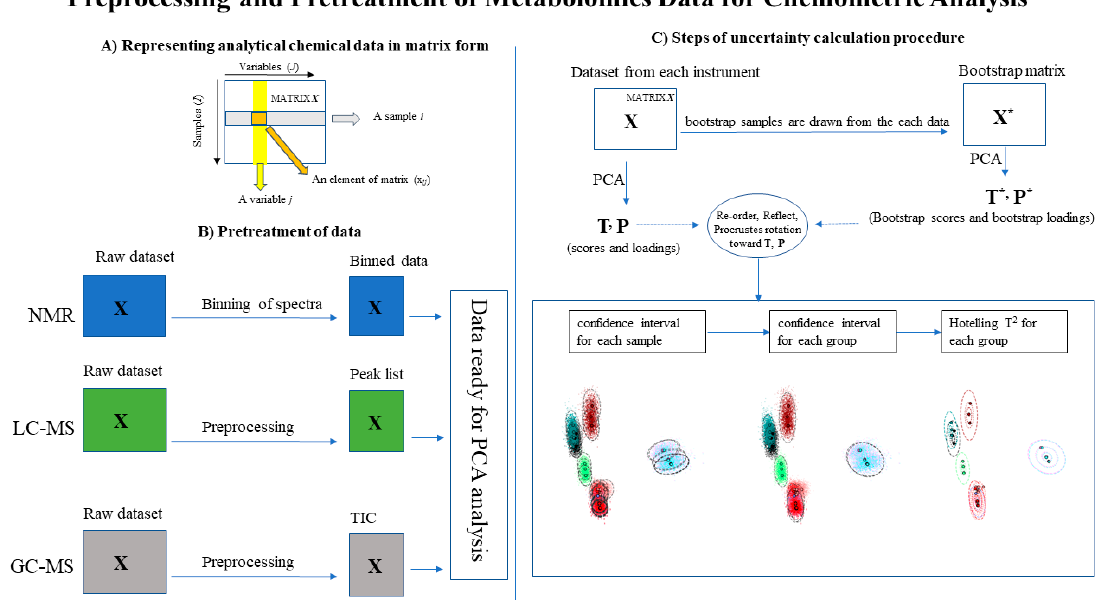
Figure 1. Preprocessing and pretreatment of the experimental data. ( A ) The matrix representation of the analytical chemical data. ( B ) The pretreatment of the raw data resulting in the processed data used for analysis. In the case of liquid chromatography mass spectrometry (LC-MS), the preprocessed data is a list of identified features. For nuclear magnetic resonance spectroscopy (NMR), the preprocessed data is binned spectra. For gas chromatography mass spectrometry (GC-MS), the preprocessed data is a total ion chromatogram (TIC). ( C ) A schematic of the uncertainty calculation using bootstrapping, described in Appendix A. The data matrix X is analyzed using principal components analysis (PCA), generating scores T and loadings P . Bootstrap matrices X* are sampled from X , generating bootstrap scores T* and loadings P* . The scores are aligned using an orthogonal Procrustes algorithm to estimate uncertainty in classifications.